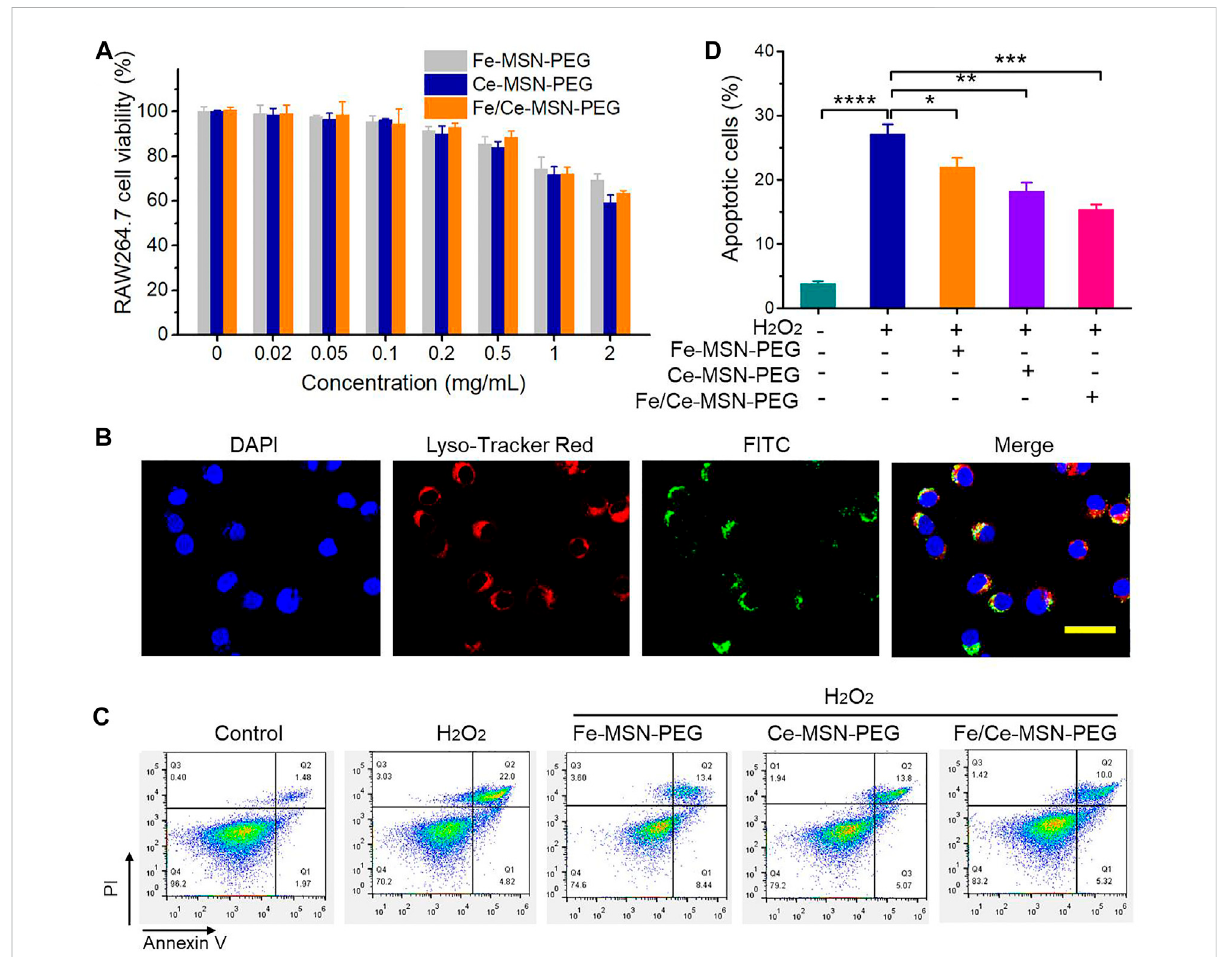
FIGURE 5 Vitro cytotoxicity, cellular uptake, and anti-oxidative stress of Fe/Ce-MSN-PEG NPs in RAW 264.7 cells. (A) In vitro cell viabilities of RAW 264.7 cells under different treatment conditions. (B) Confocal microscopy observed of the cellular uptake of NPs in RAW 264.7 cells. Nuclei were stained with DAPI (blue), lysosomal were stained with Lyso-Tracker Red (red), while NPs were labeled with FITC (green) (At scale 10 µm). (C,D) Flow cytometric pro fi les and quantitative data of apoptotic RAW 264.7 cells after different treatments. Data are presented as mean ± SE ( n = 3). * p < 0.05, ** p < 0.01, *** p <